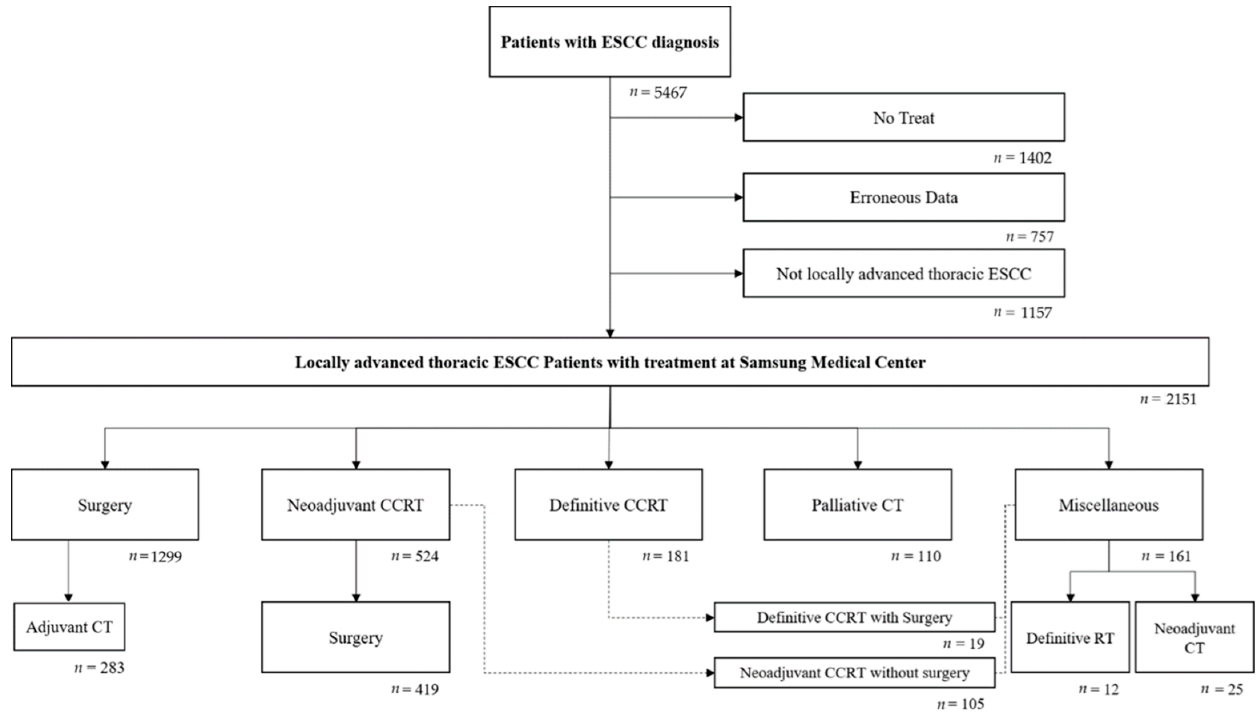
Figure 1. Eligibility process.